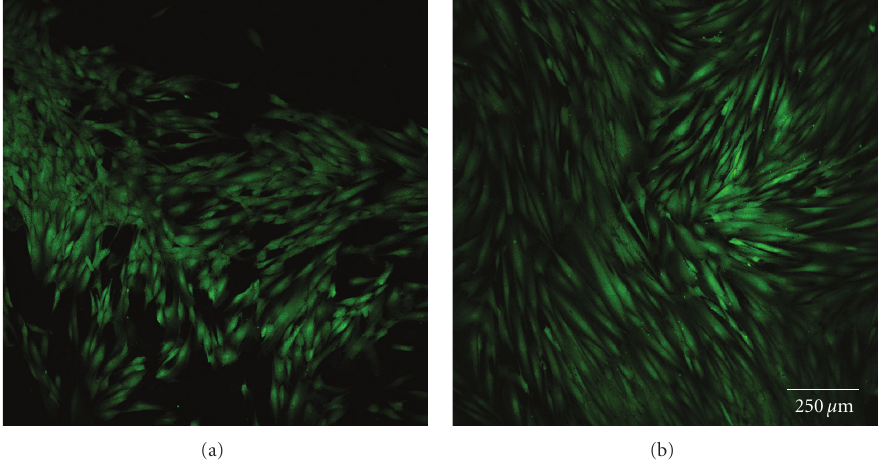
Figure 7: Fibroblast cells cultured on purified glass after 24 h (a) and 72 h